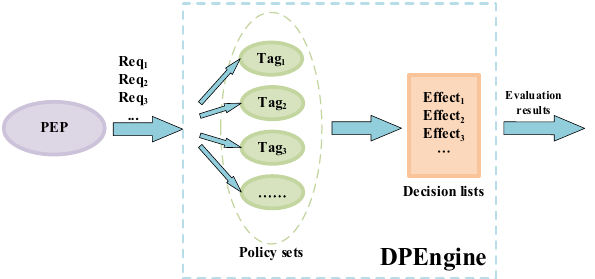
Figure 7. Process of policy